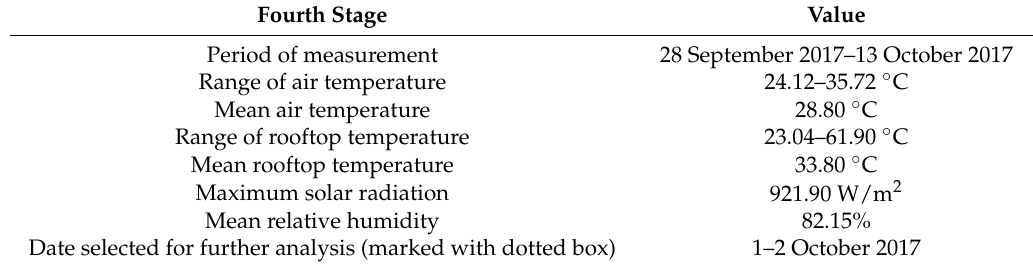
Table 11. Weather data for the fourth stage (28 September 2017 06:07:57 to 13 October 2017 05:57:57). Fourth Stage Value Period of measurement